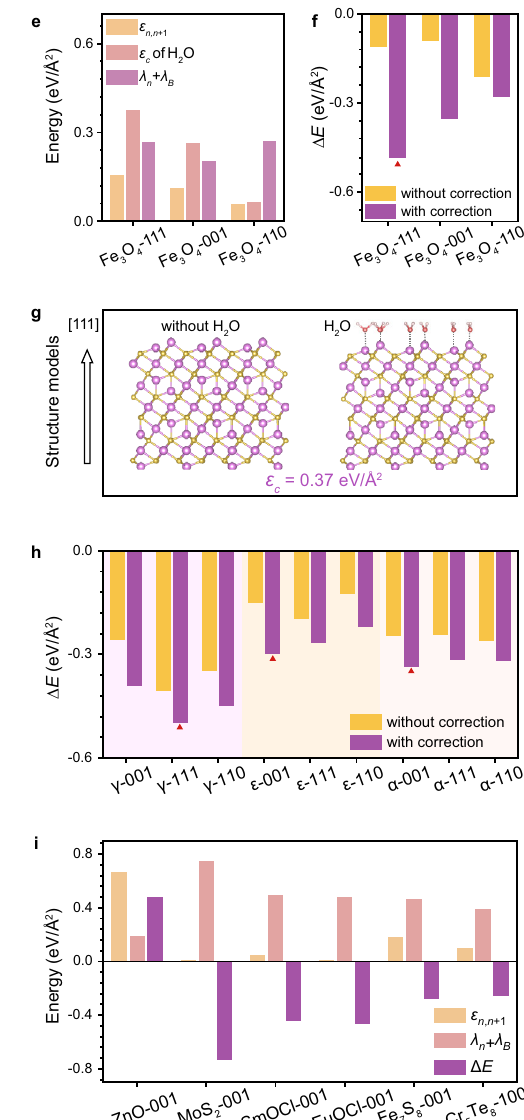
Fig. 1 | The thermodynamics-triggered competitive growth (TTCG) model. a Schematic illustration of ε i , i +1 and λ i in the Eq. (1) and the representations in nonlayered and layered materials. ε i , i +1 and λ i refer to the interaction energy per unitareabetweensubunit i and i +1,andtheedgeenergyperunitareaofsubunit i , respectively. b Sketch map of vertical and lateral growth when a new cluster (yellow) grows with the n stacking subunits (lilac). The free energy change of vertical growth mainly comes from the interaction of subunit at the upper inter- face, while edge energy penalty is dominant for lateral growth. Δ E ver and Δ E lat represent the free energy change of vertical and lateral growth. ε n , n +1 denotes the interaction energy between subunit n and n +1. λ n and λ B represent the average edge energies of the initial structure and the new cluster, respectively. A s are the basal and lateral contact areas. c The competition between ε term and λ term. Smaller ε term will promote lateral growth and smaller λ term leads to